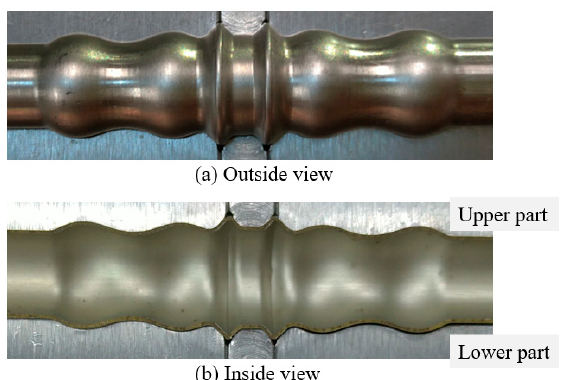
Figure 14. Appearance of hydroformed product after loading path stage II. (L = 1.47 mm, P 1 = 70.2 MPa).